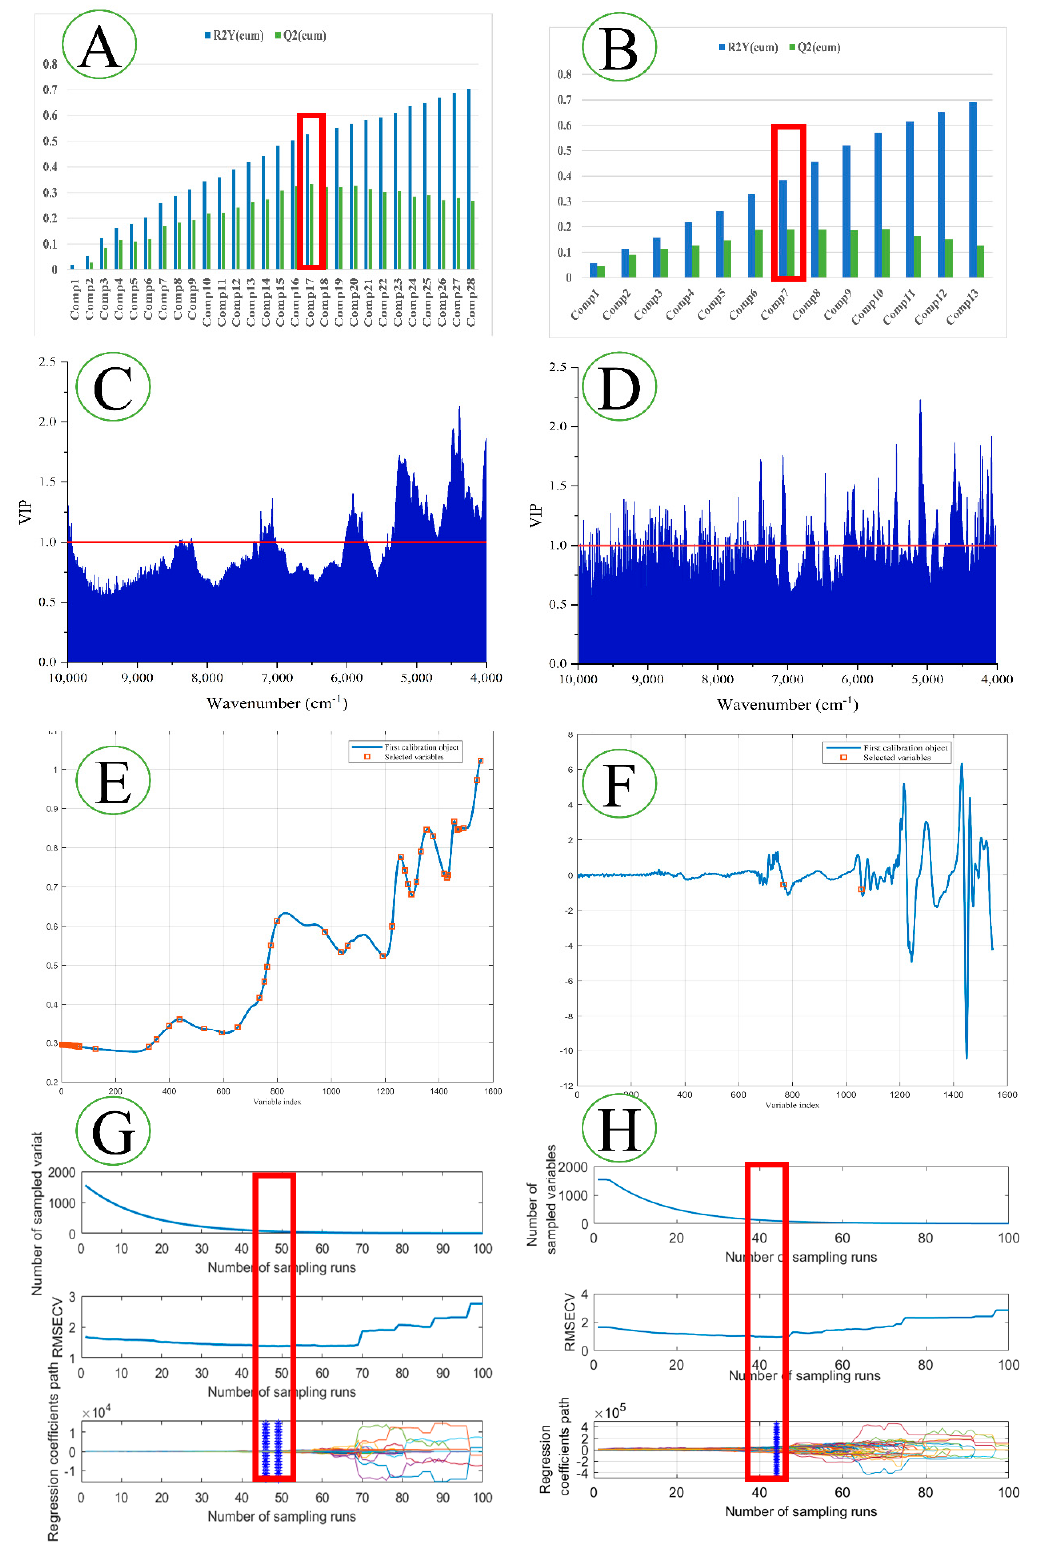
Figure 4. Four processes for manually extracting FT-NIR feature variables. ( A , C , E , G ) are the selection processes of the original spectra, ( B , D , F , H ) are the selection processes after preprocessing. ( A ) and ( B ) are LVs, ( C ) and ( D ) are for VIP, ( E ) and ( F ) for SPA, and ( G ) and ( H ) are for CARS. The red boxes represent the variables selected.